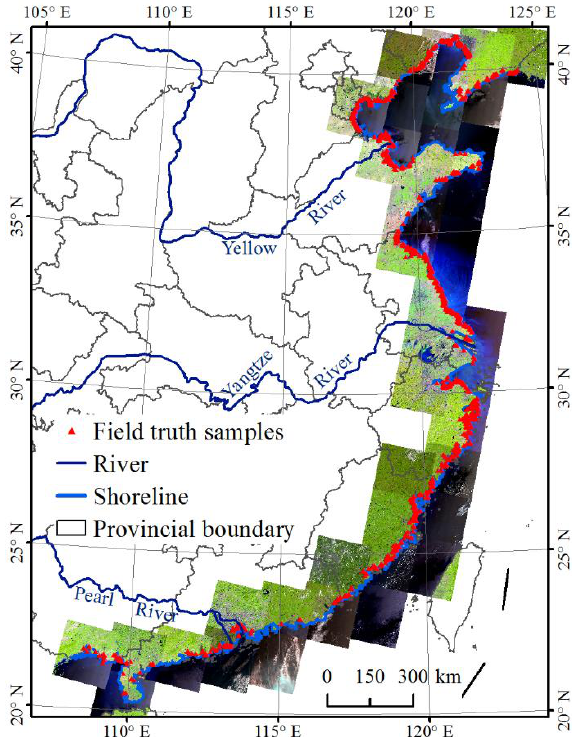
Figure 2. Landsat image coverage in 2015 and distribution of field ground-truth samples in 2015.